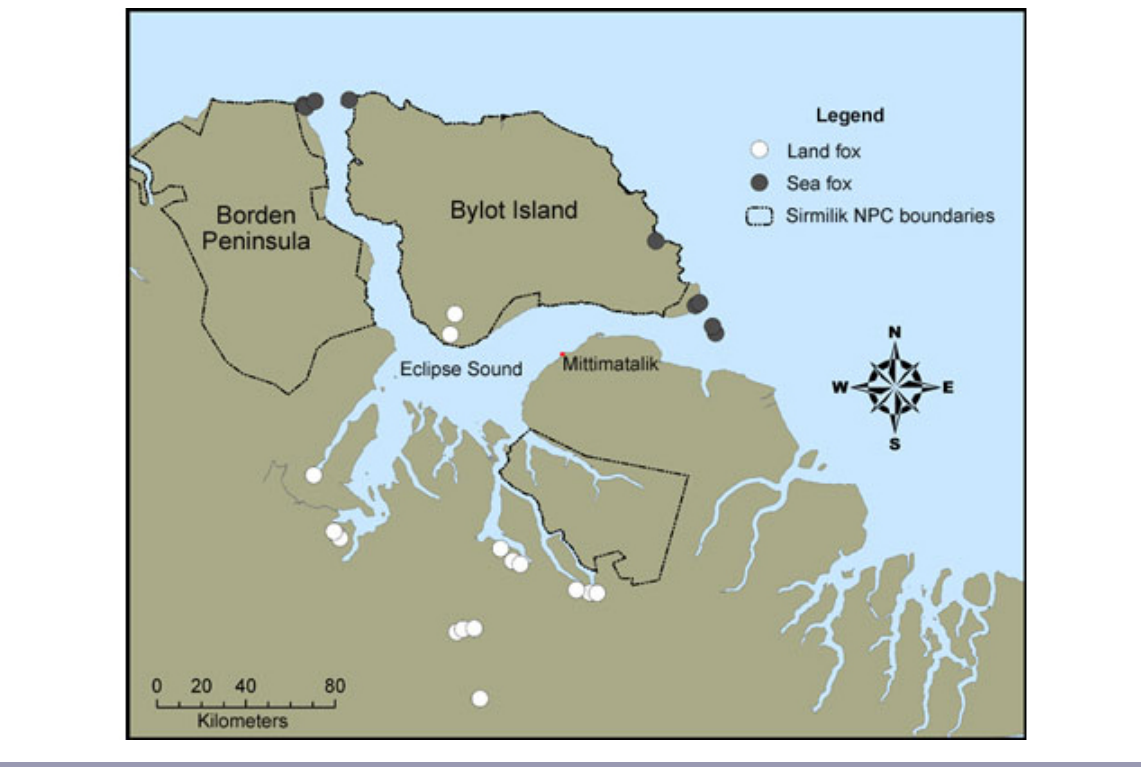
Fig. 3 . General spatial distribution of “land” and “sea” arctic fox ( Vulpes lagopus ), according to the traditional ecological knowledge reported by local experts from Mittimatalik, Nunavut,